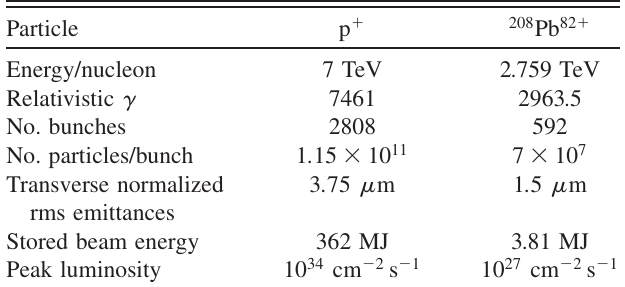
TABLE I. The parameters for the p þ and 208 Pb 82 þ LHC beams at